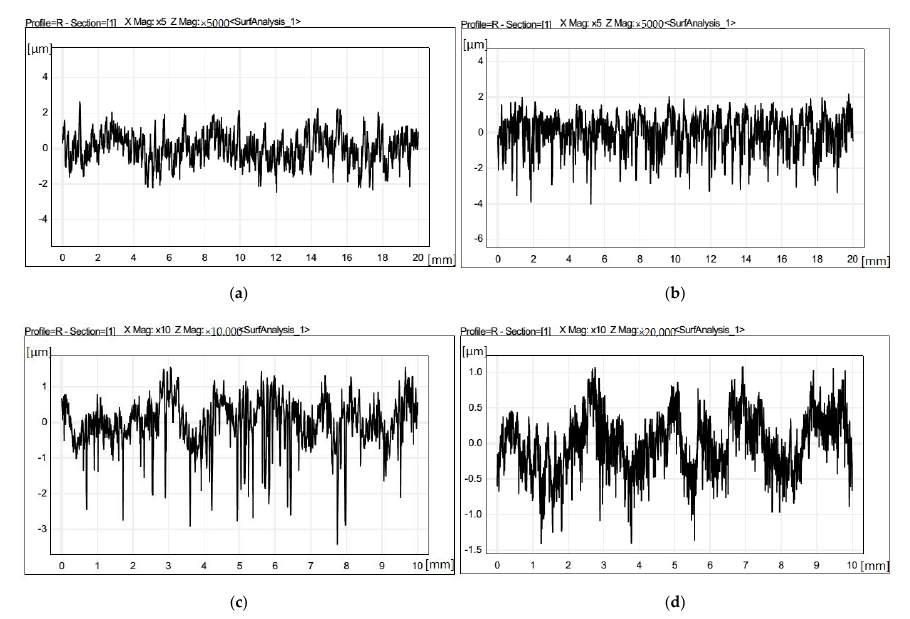
Table 5. Experimental results.